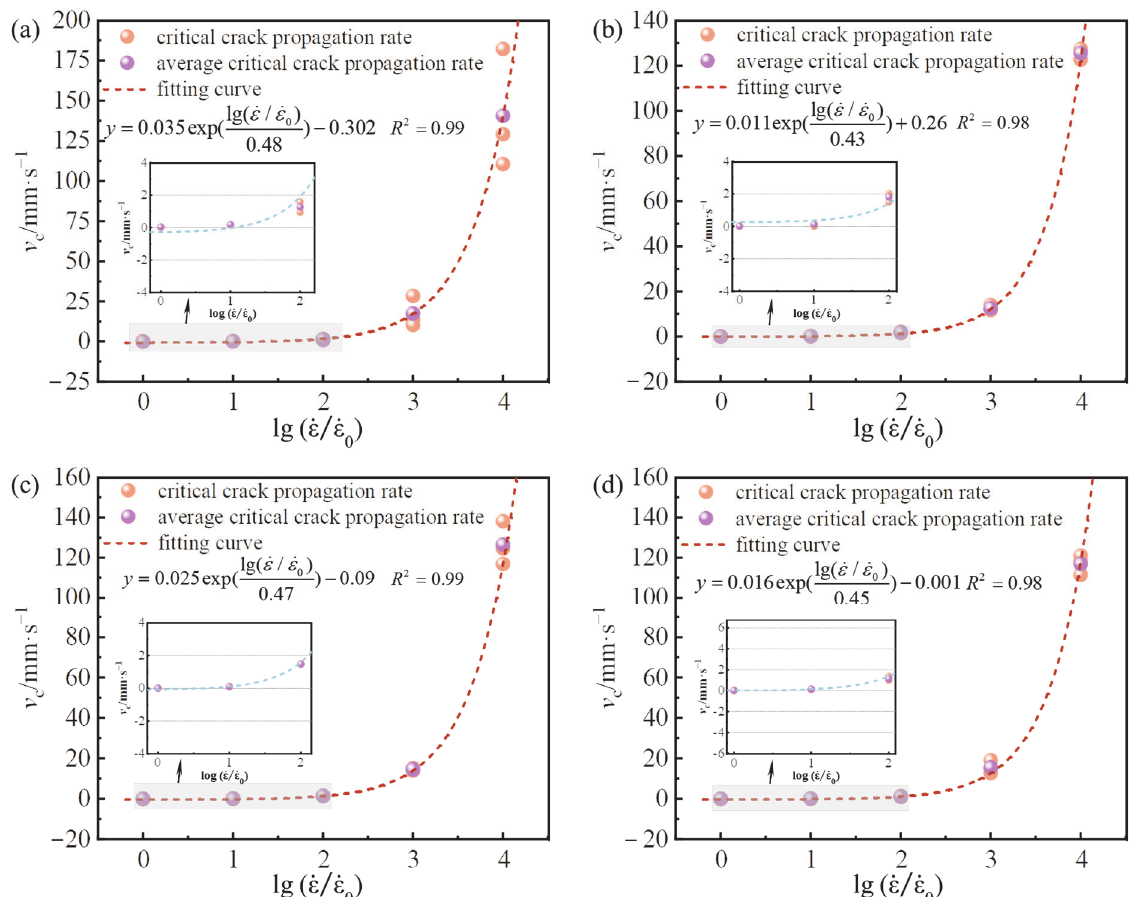
Figure 16. Critical crack propagation velocities at various loading rates: ( a ) OPC; ( b ) B ‐ 0.2; ( c ) B ‐ 0.4; and ( d ) B ‐ 0.6.